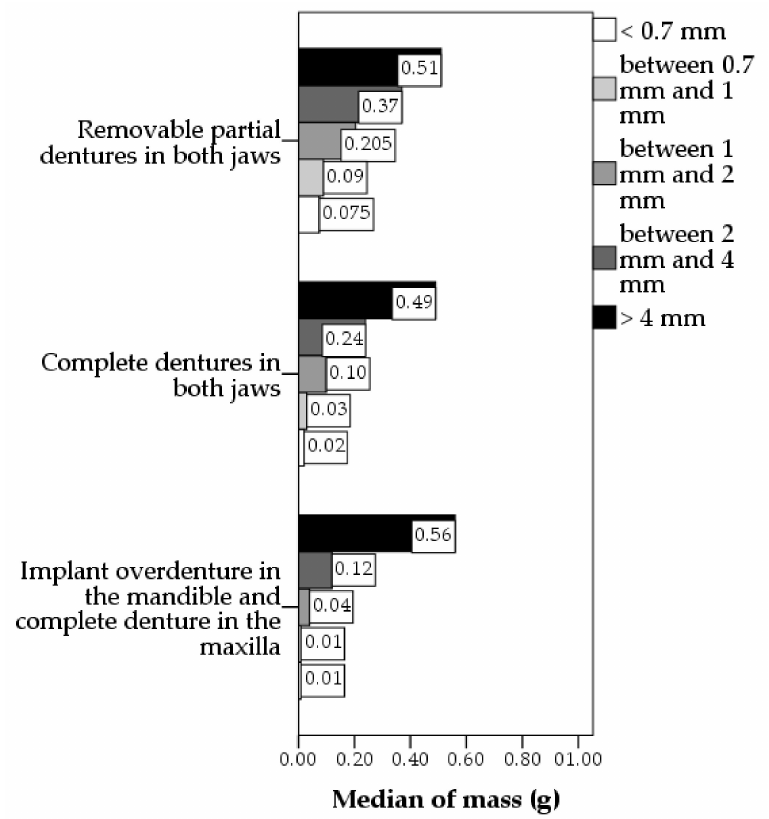
Figure 3. Particle size distribution in patients with removable prostheses rehabilitations that were most frequently encountered in this